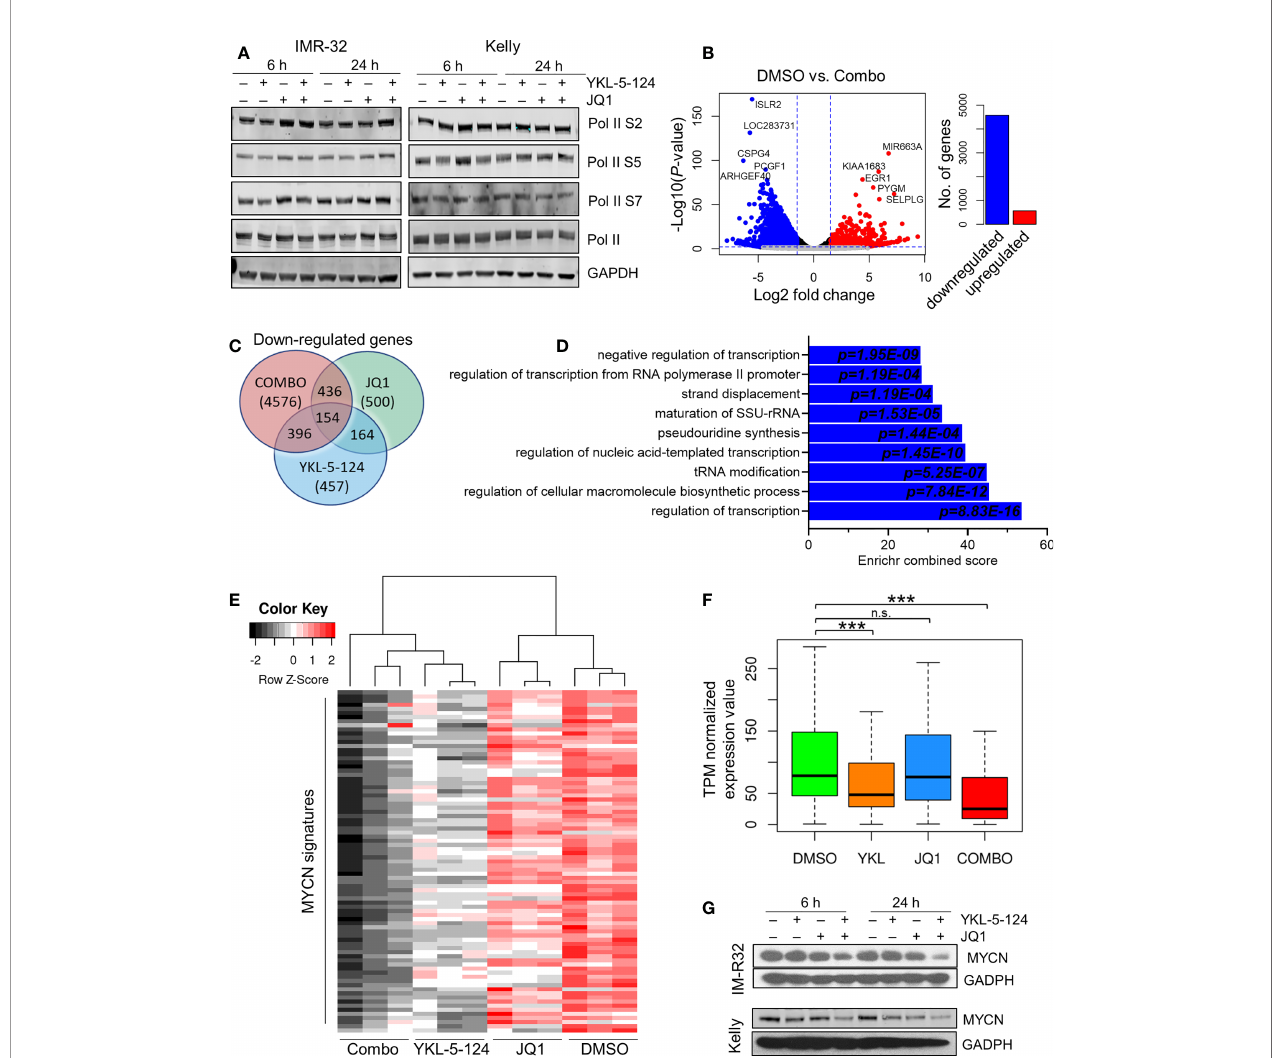
FIGURE 4 | Combined inhibition of CDK7 and BRD4 affects RNA Pol II transcription. (A) WB analysis of Pol II phosphorylation in NB cells treated with 100nM YKL- 5-124, 400 nM JQ1, or the combination at the indicated concentrations for the indicated times. (B) Volcano plot of differentially expressed genes following treatment with the combination of 100 nM YKL-5-124 and 400 nM JQ1 for 4 h ( left ). The fold changes are represented in log2 scale (x-axis), and the − log10 P -value depicted on the y-axis (FDR < 0.01 and log2 FC >1.5). Bar plot depicts the numbers of up- and downregulated genes ( right ). (C) Venn diagram representing downregulated genes (FC >1.5 and FDR ≤ 0.01) in NB cells treated with 100 nM YKL-5-124, 400 nM JQ1 or the combination. (D) GO enrichment analysis of genes signi fi cantly downregulated in NB cells after treatment as in (B) . (E) Heat map of expression values of the MYCN gene signature in RNA-seq analysis of NB cells treated with 100 nM YKL-5-124, 400 nM JQ1, or the combination for 4 h. The MYCN 87-gene signature was established in Valentijn et al. (30). (F) Box plots comparing gene expression changes in the MYCN signature within the indicated data sets. The center line indicates the median for each data set. Signi fi cance was determined by Welch ’ s two-sample t-test (*** P < 0.001); n.s., not signi fi cant. (G) WB analyses of MYCN expression in NB cells treated with 100 nM YKL-5-124, 400 nM JQ1 or the combination at the indicated concentrations for the indicated